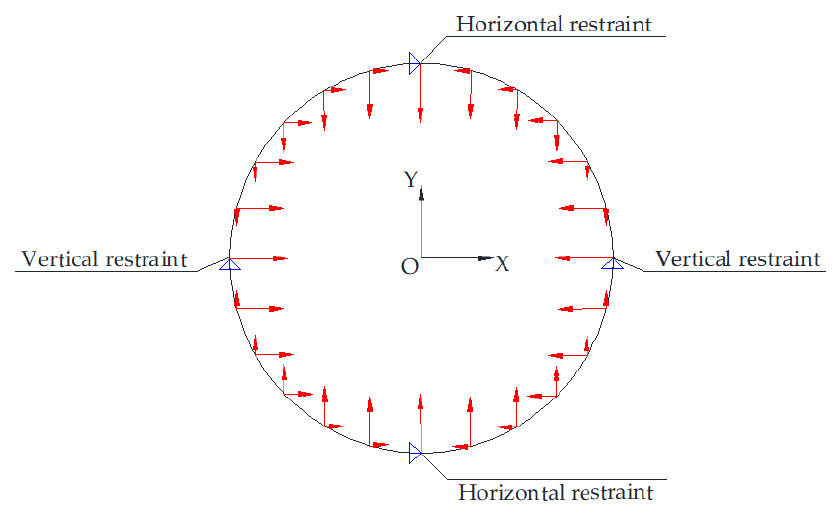
Figure 3. Beam-spring model. Table 2. Joints’ bending stiffness obtained through back analysis.